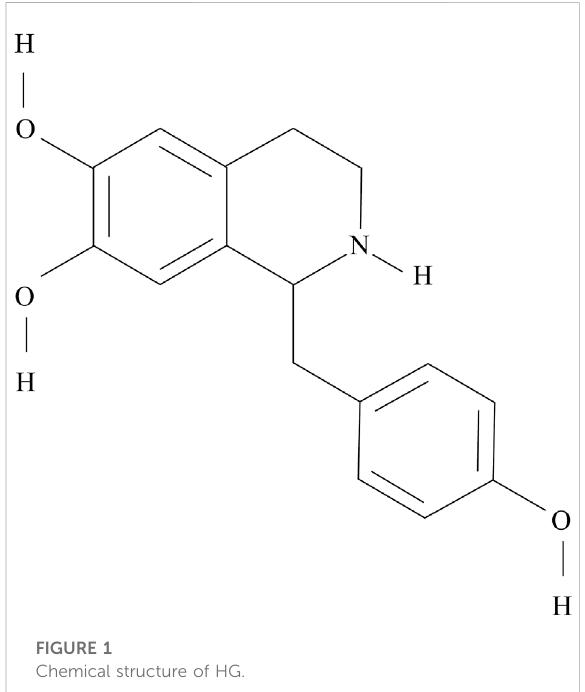
FIGURE 1 Chemical structure of